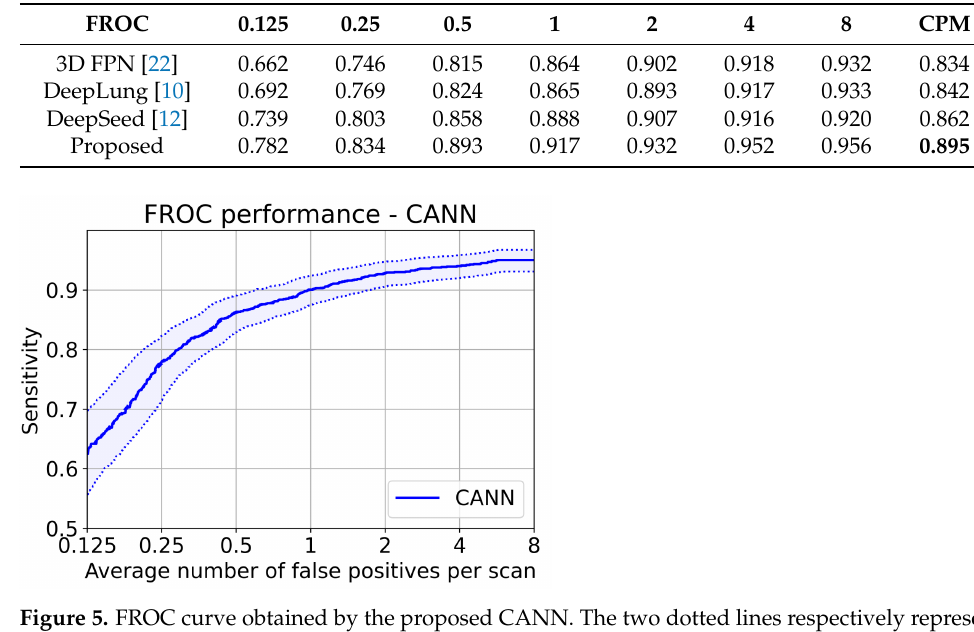
Figure 5. FROC curve obtained by the proposed CANN. The two dotted lines respectively represent the upper and lower boundaries after